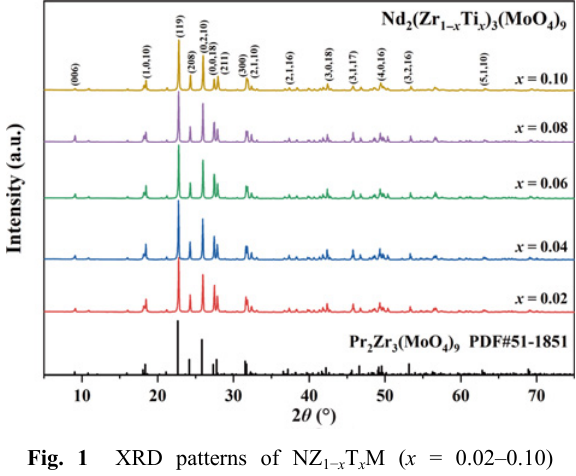
XRD patterns of NZ 1 − x T x M ( x = 0.02–0.10) ceramics sintered at optimal temperatures.